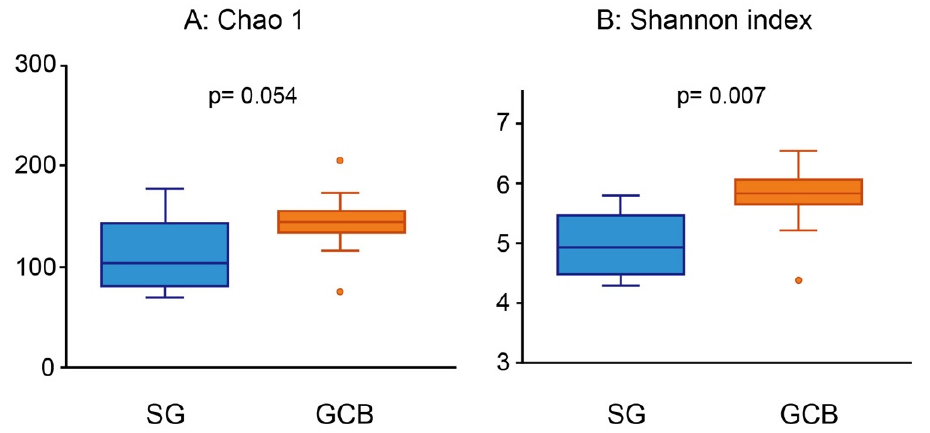
Figure 2. Alpha diversity analysis using Chao 1 ( A ) and Shannon index ( B ). The root caries lesions collected from 22 participants are divided into two groups according to the location of the lesion. Each value is presented as a box plot. The top, middle, and bottom lines of the boxes represent the 25th, 50th (median), and 75th percentiles, respectively. The significance of differences between the two groups is evaluated. p values < 0.05 are considered to indicate statistical significance. SG: root caries that existed independently above the gingival margin, GCB: root caries that progressed below the gingival margin.